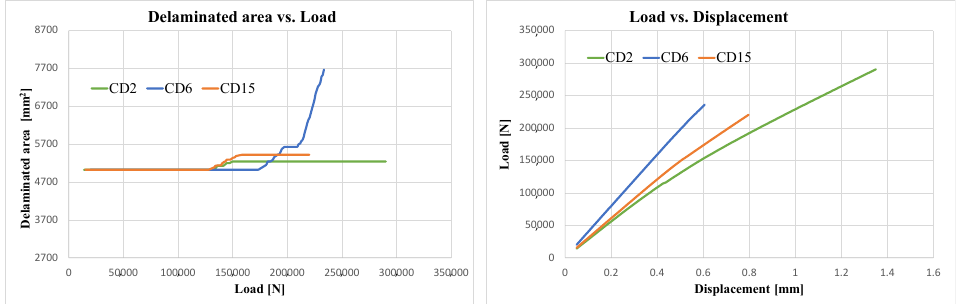
Figure 15. Delaminated area vs. load and load vs. displacement charts. Comparison against CD2, CD6 and CD15 configurations.